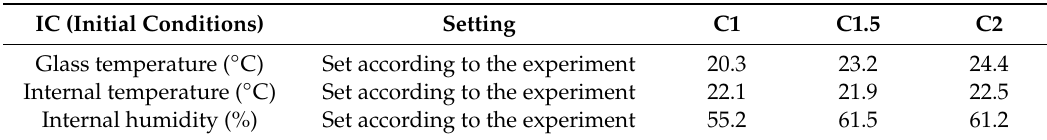
Table 3. Initial conditions for the fogging phase simulation.